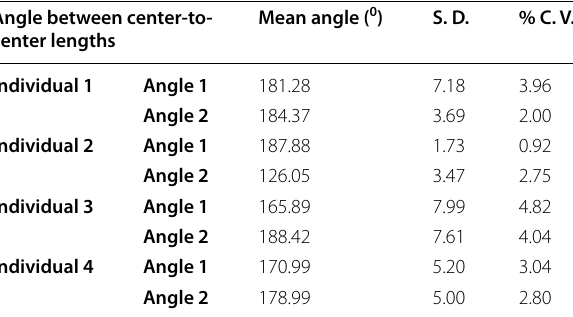
Table 11 Mean angle between center-to-center lengths, standard deviation (S. D.), and % coefficient of variation (% C.V.) of four pores, taken from fingerprints obtained from the right thumb of four individuals on sticky side of adhesive tape (using method described in (iii)), recorded on ten consecutive days, show % C. V. to be within the normal acceptable level (with 5% confidence level in analytical work)